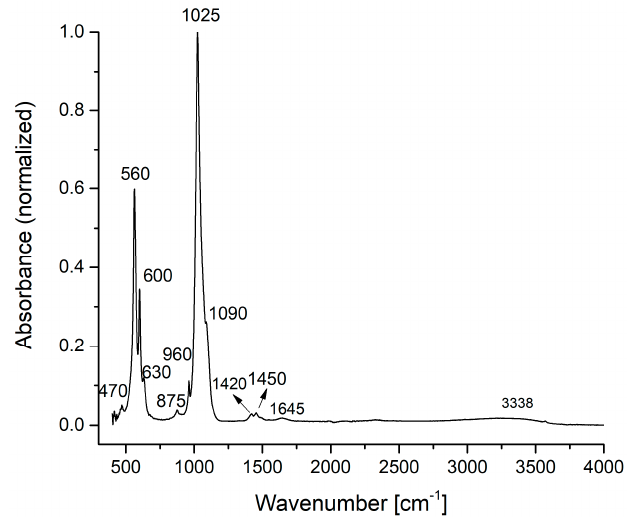
Figure 2. FTIR spectra of the HAp sample.